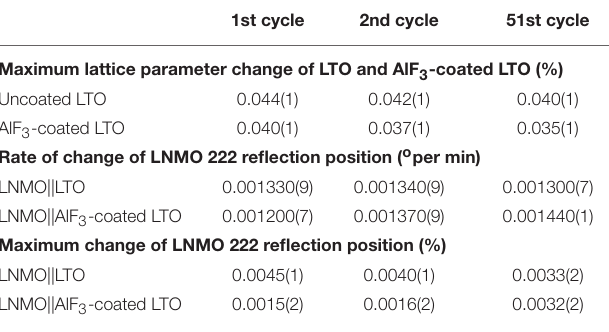
TABLE 3 | Comparison of maximum change of the coated and uncoated LTO lattice parameter, as well as the corresponding rate of change and maximum